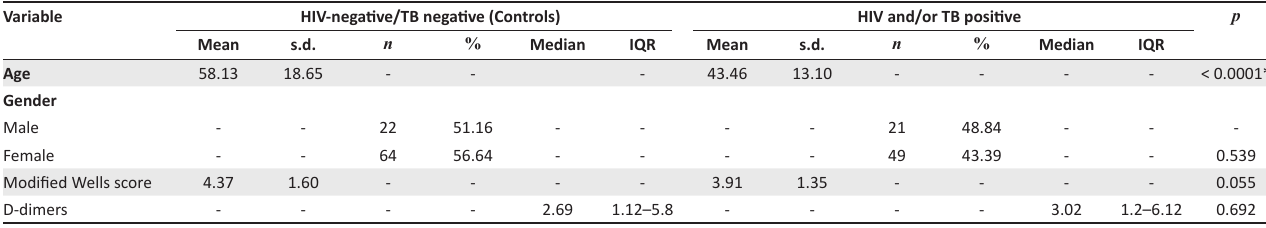
TABLE 2 : Comparison of cases and controls ( n = 156). Variable